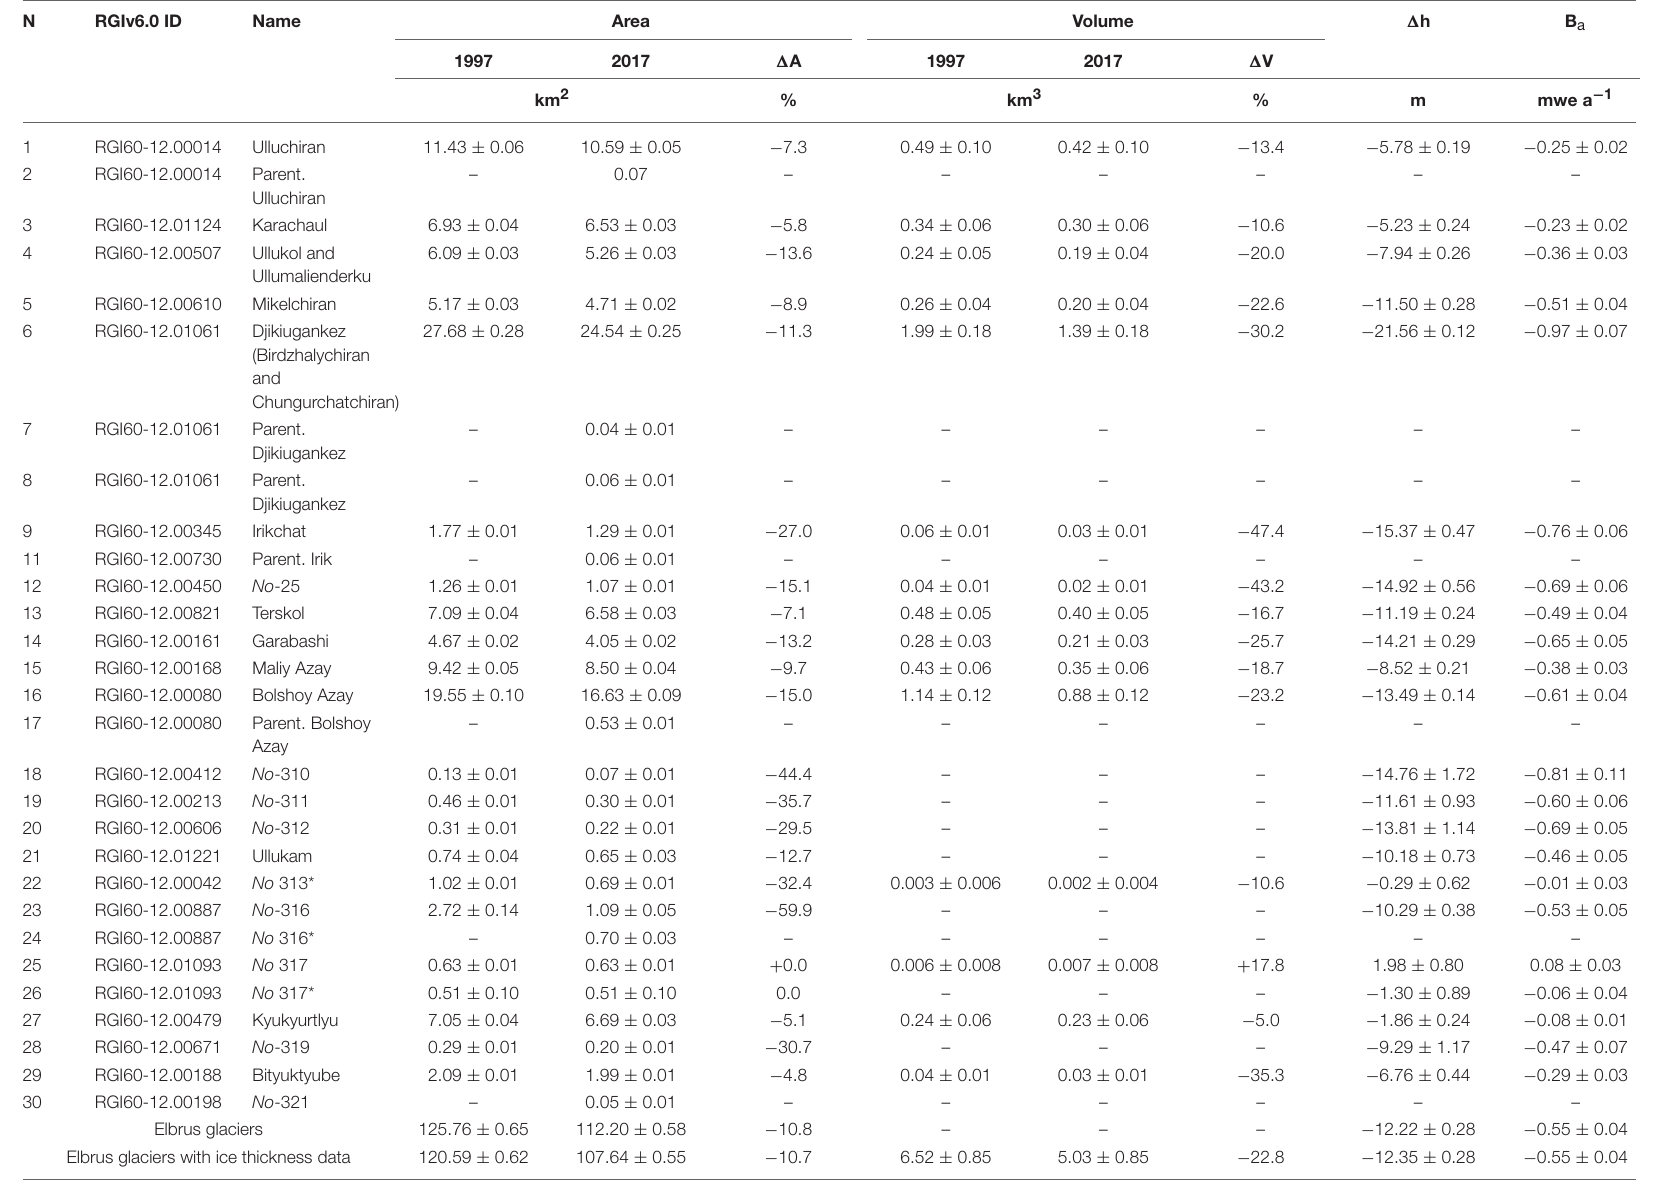
TABLE 2 | Volume, area and elevation changes, together with geodetic mass balances, for the entire Elbrus area and individual glaciers. N RGIv6.0